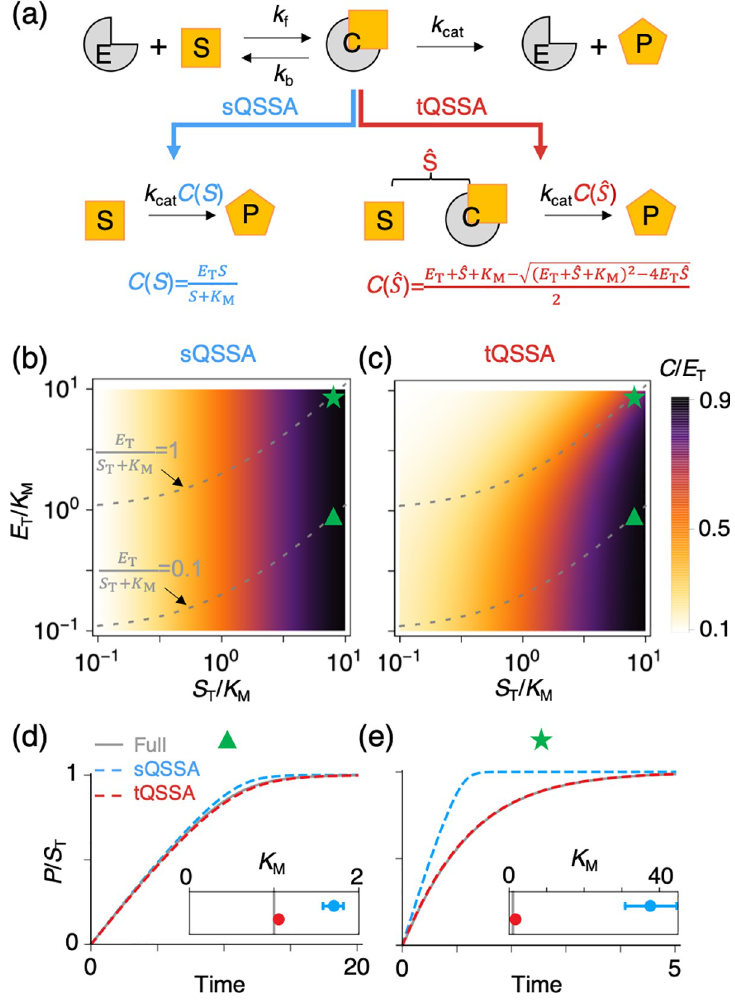
Fig 1. Comparison of the sQSSA and tQSSA for an enzyme-catalyzed reaction. (a) The MM mechanism for a single-substrate enzyme-catalyzed reaction; S, substrate; E, enzyme; C, enzyme-substrate complex; P, product. Note that we use a different font style to distinguish a substance, S, from its concentration, S in Eq 1. The full model, based on mass-action kinetics (Eq 1), can be simplified by either the sQSSA (Eq 3) or the tQSSA (Eq 5). Both approximations assume that C rapidly reaches a QSSA, which is solely determined by either S (Eq 2) or ^ S ¼ S þ C (Eq 4). (b–c) Heat maps of the predicted maximal fraction of total enzyme that is in complex with substrate, i.e., C ( S T )/ E T , predicted with sQSSA (Eq 2) and tQSSA (Eq 4). In these panels, color represents the ratio C ( S T )/ E T , and gray dashed lines are contours of E T /( K M + S T ) = 0.1 and 1.0. The sQSSA (Eq 2) predicts that this fraction is independent of total enzyme concentration, E T (e.g., C ( S T )/ E T = 0.5 when S T = K M regardless of E T ) in panel b. On the other hand, the tQSSA (Eq 4) predicts that, as E T increases, more substrate is needed to achieve that same level of substrate saturation of enzyme molecules in panel c. When the validity condition for the sQSSA holds (i.e., below the gray dashed line where E T /( K M + S T ) � 1), the predictions of the two models are nearly identical. (d–e) The simulated accumulation of P and the estimation of the Michaelis constant, K M , from the progress curve of P . For these calculations, we chose k f = 10, k b = 9, k cat = 1, K M = 1, S T = 9, and E T /( K M + S T ) = 0.1 (panel d; triangle mark in (b) and (c)) or 1 (panel e; star mark in (b) and (c)). Initial conditions are S (0) = S T , C (0) = 0, P (0) = 0. If E T is low (i.e., E T /( K M + S T ) = 0.1), the simulation of P and the estimation of K M with the sQSSA model are accurate (d). On the other hand, if E T is high (i.e., E T /( K M + S T ) = 1), the simulated P with the sQSSA model using the true rate constants is wildly divergent from the true progress curve simulated with the full model (e). As a result, if k cat and K M are adjusted to fit the sQSSA model to the true progress curve, then the estimates of k cat and K M are far from the true values (inset; the estimates of k cat is not shown). On the other hand, the tQSSA model accurately reproduces the progress curve of P and estimates the rate constants regardless of the value of E T (d and e). Inset: gray lines are the true value of K M , and the red and blue circles are the mean K M estimates from the tQSSA and sQSSA models, respectively. The bars represent 99% confidence intervals. The Quasi- Newton method is applied to 21 sampled points of the progress curve of P simulated with the full model to identify the value of K M that minimizes the fitting error of the sQSSA and tQSSA models. The true values of parameters are used